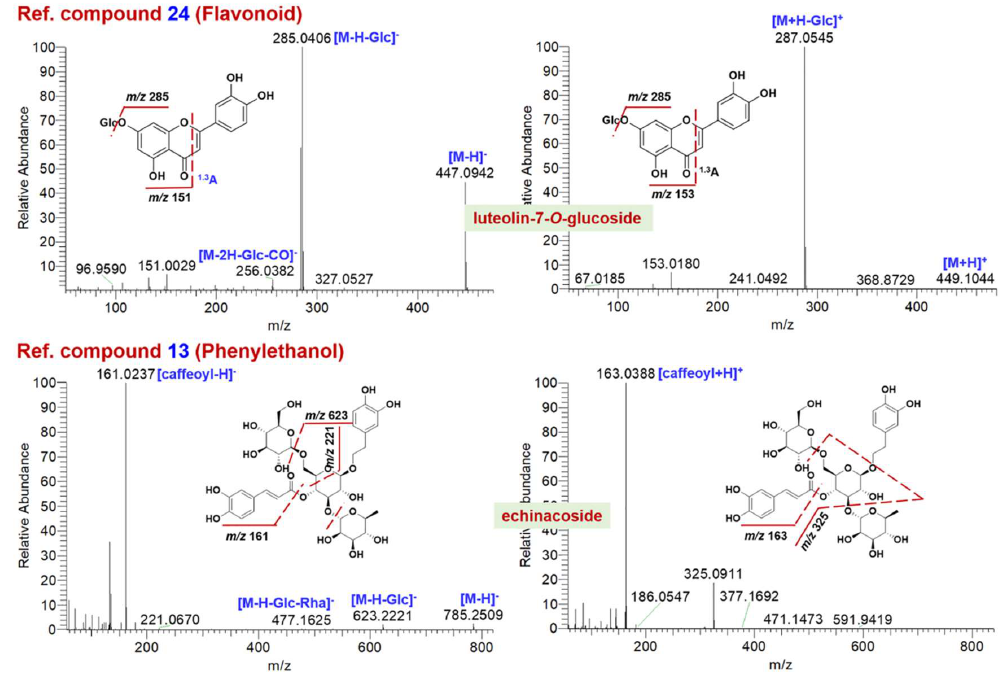
Figure 3. Annotation of the HCD-MS 2 data for reference compounds 24 (Flavonoid) and 13 (Phenylethanol) obtained in both negative and positive ESI modes.